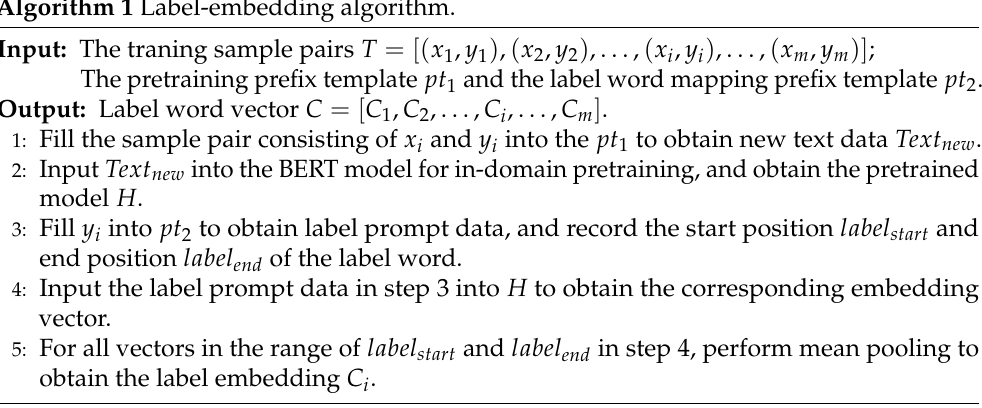
Algorithm 1 Label-embedding